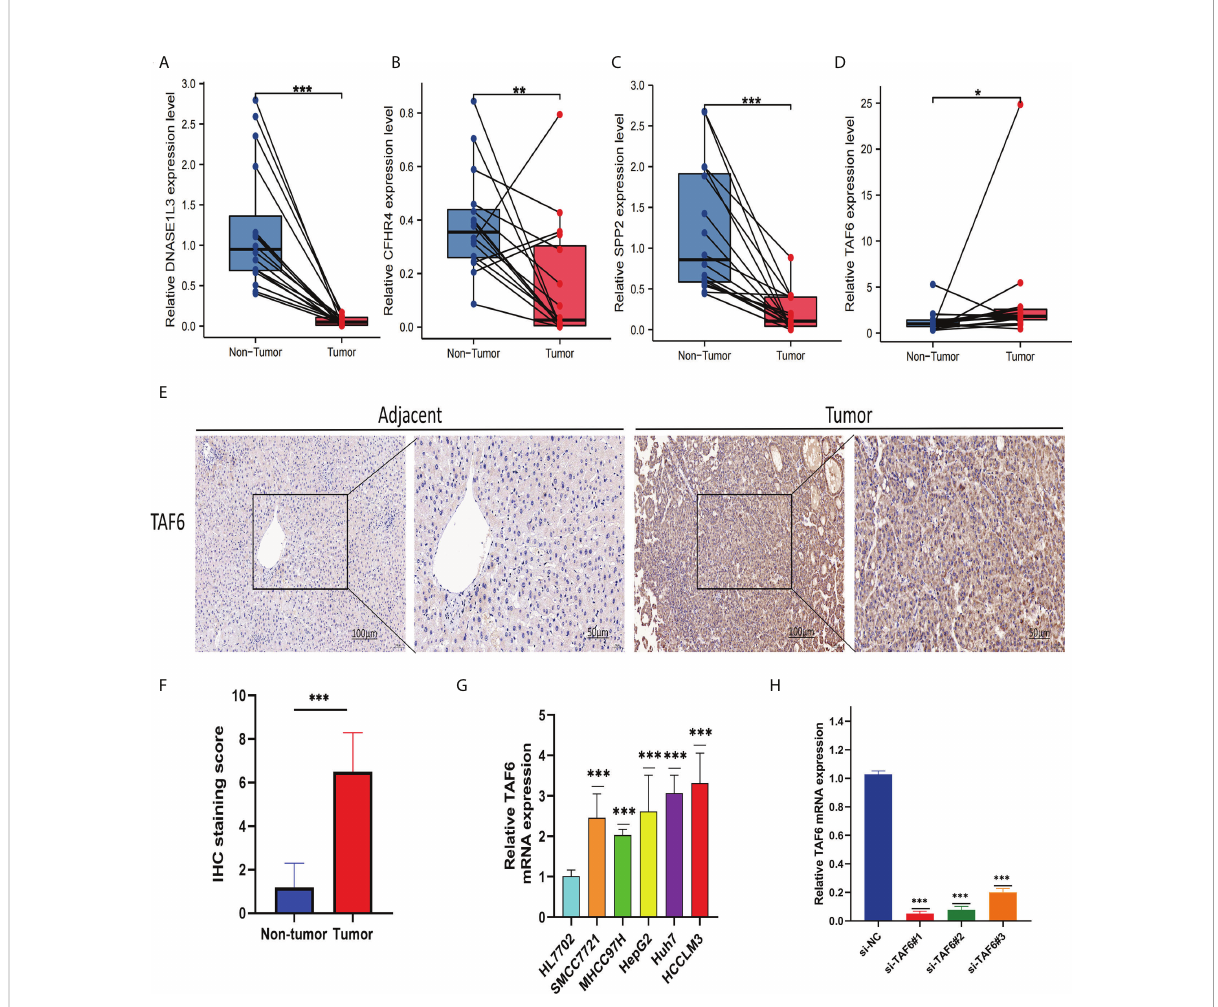
FIGURE 12 Verify the mRNA expression levels of the four signature genes in the tissues. The qRT-PCR results showed thatDNASE1L3 (A) , CFHR4 (B) , and SPP2 (C) were expressed higher in non-tumor tissues (Non-Tumor) than in tumor tissues (Tumor), TAF6 (D) was expressed higher in tumor tissues (Tumor)than in non-tumor tissues (Non-Tumor). TAF6 representative IHC (E, F) stained images in HCC tissue and adjacent tissues(n = 16; magni fi cation: left, 100×; right, 200×). Expression levels of TAF6 (G) in HCC cell lines. The bar graphs (H) indicates better silencing for si-TAF6#1 and si-TAF6#2. *p< 0.05, **p< 0.01, and ***p<